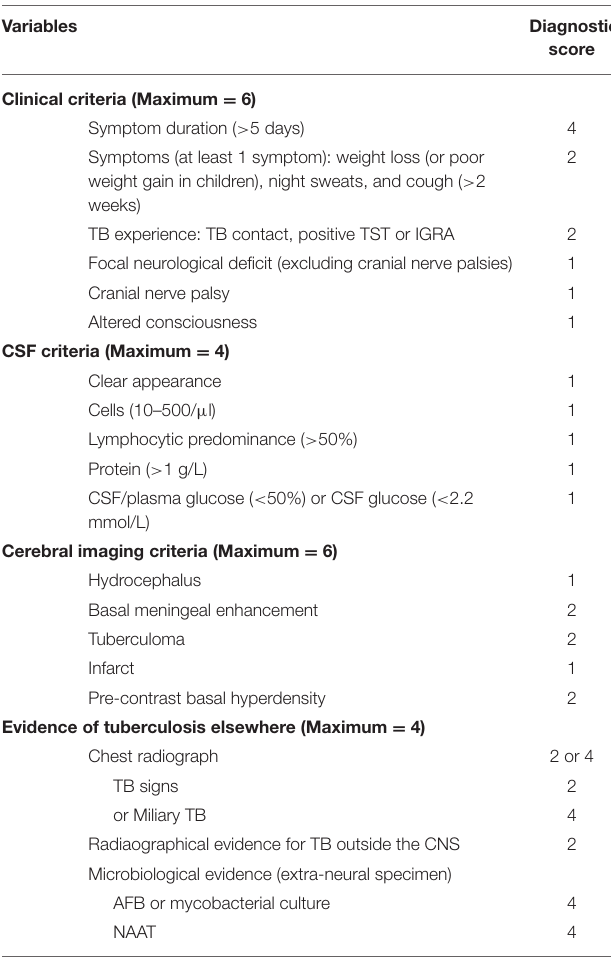
TABLE 1 | Diagnostic items and corresponding scores for tuberculous meningitis